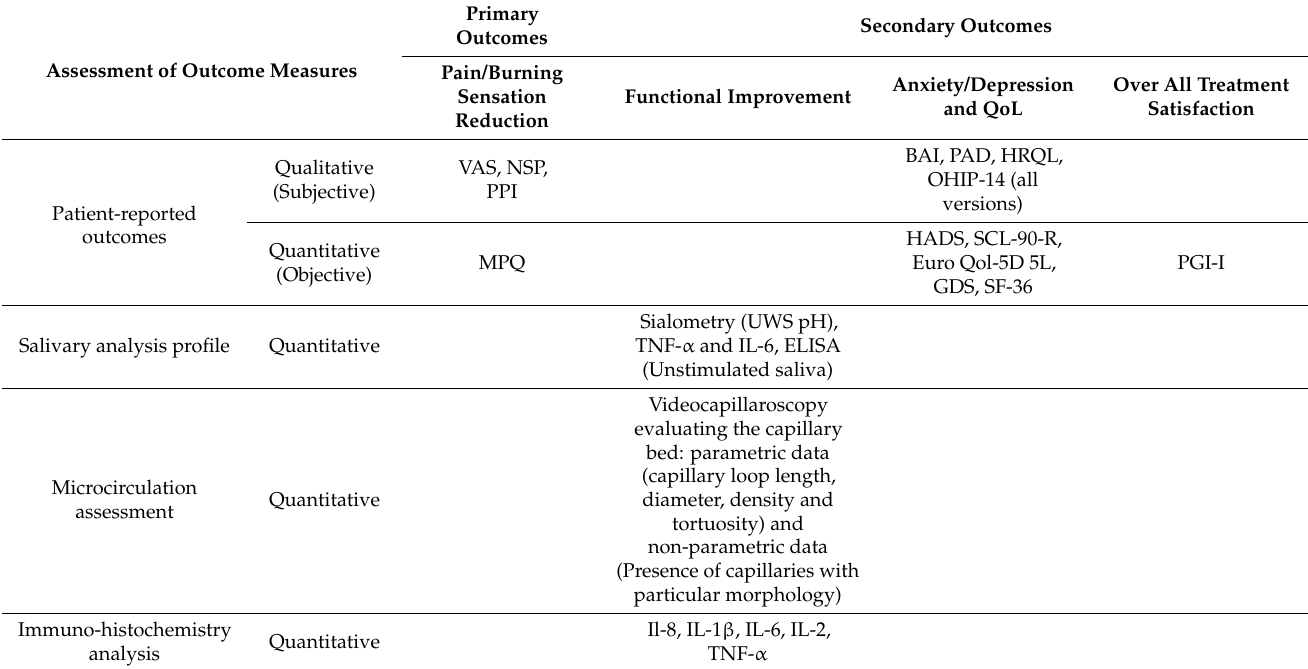
Table 1. Illustrates the qualitative and quantitative measurements for primary and secondary outcomes utilized in the selected studies of this review. Abbreviations: VAS: visual analogue scale; NSP: Numerical scale of pain; PPI: present pain intensity; PAD: pleasure–arousal–dominance; BAI: beck anxiety inventory; HRQL: health-related quality of life; MPQ: McGill Pain Questionnaire; QHIP-14: health impact profile-14; HADS: Hospital Anxiety And Depression Scale; PGI-I: patient global impression of improvement; GDS: geriatric depression scale; SF-36: short Form-36 Health Survey Questionnaire; SCL 90-R: Symptom Checklist-90-R; UWS pH: unstimulated whole salivary flow-pH; ELISA: enzyme-linked immunosorbent assay. List of the abbreviations are listed in Supplementary File